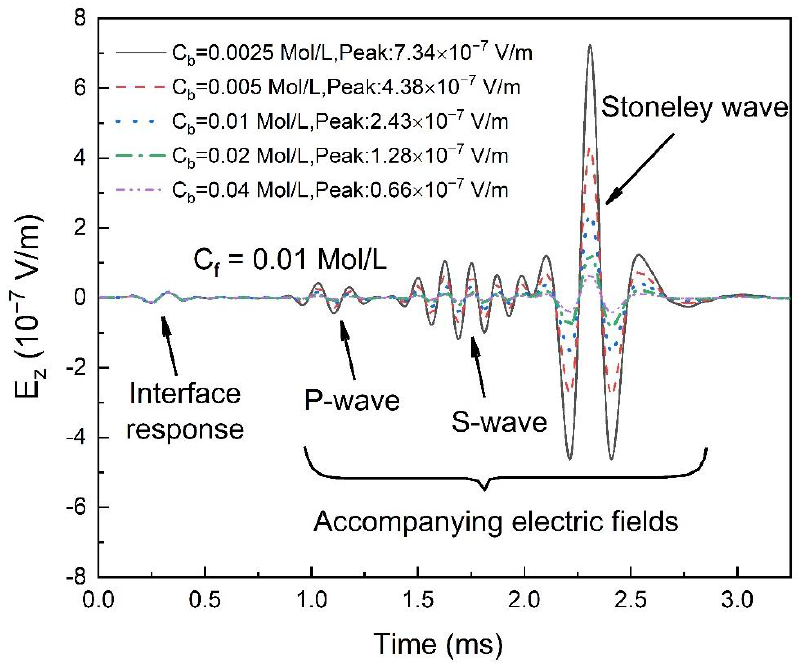
Figure 6. Axial electric fields for different borehole fluid salinity levels. The solid line, dashed line, dotted line, dash dotted line, and double-dot dashed line correspond to the borehole fluid salinity of 0.0025, 0.005, 0.01, 0.02, and 0.04 Mol/L, respectively.